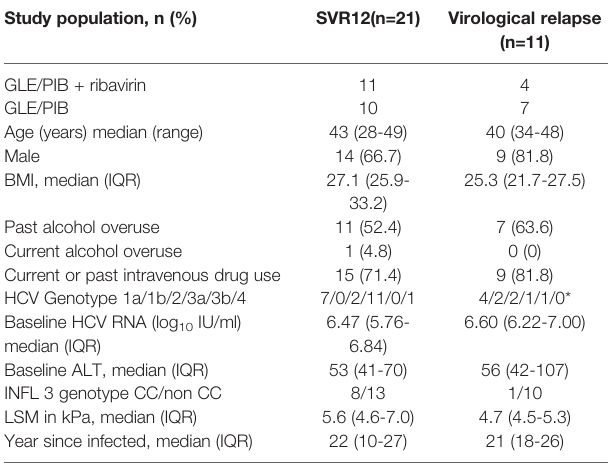
TABLE 1 | Baseline demographic and clinical characteristics of study patients according to SVR12 status after treatment. Study population, n